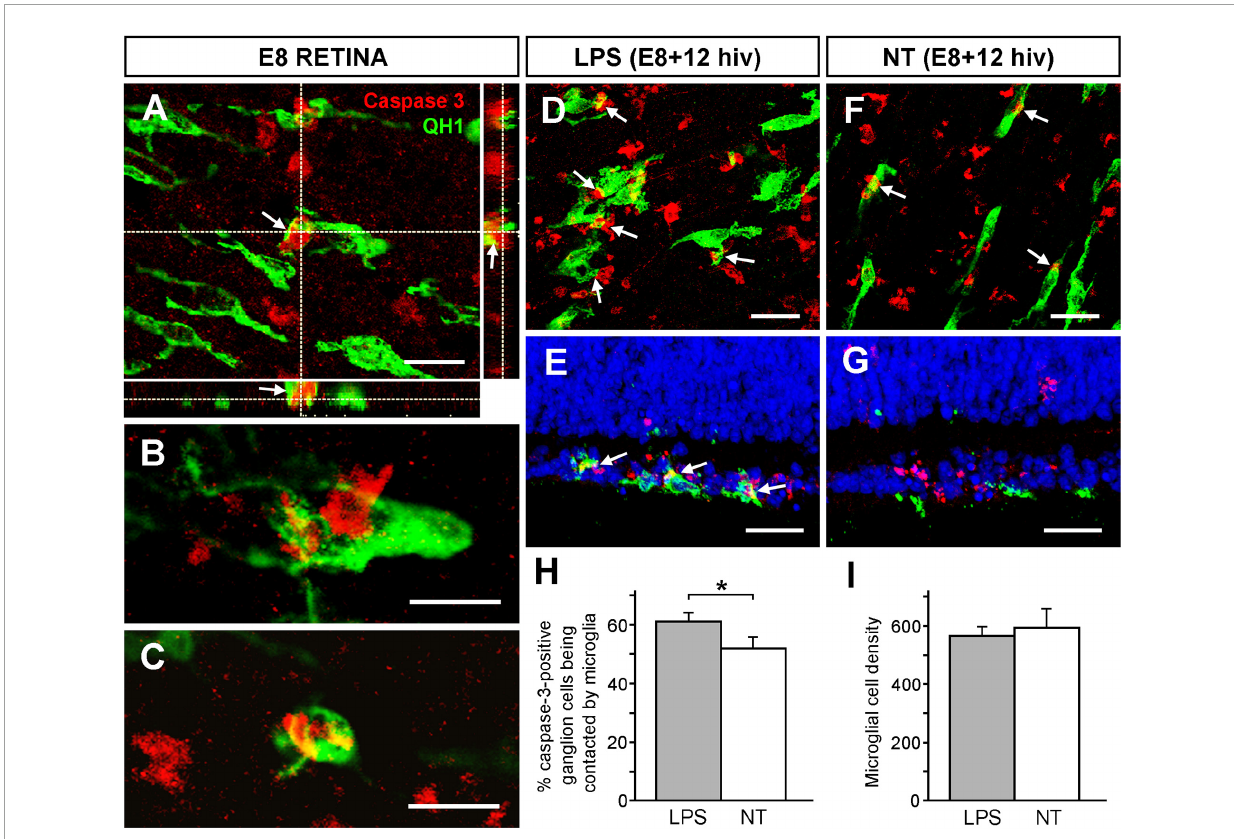
FIGURE4 Increase of phagocytic contacts between microglial cells and caspase-3-positive ganglion cells. The frequency of phagocytic contacts between microglial cells and caspase-3-positive ganglion cells increases in response to LPS treatment in retina explants from E8 quail embryos cultured for 12 h in vitro (E8 + 12 hiv). (A–C) Confocal images of microglial cells forming close engulfing contacts with caspase-3-positive ganglion cells in whole-mounted non-cultured E8 quail embryo retina explants, (E8 RETINA) double immunolabeled with QH1 (green) and anti-caspase-3 (red). These images are maximum-intensity projections from Z stacks of confocal optical sections throughout the thickness of the ganglion cell layer (GCL). Panel (A) shows a process from a microglial cell that contacts and embraces a caspase-3-positive ganglion cell. The XZ and YZ orthogonal projections corroborate the close contact (arrows) between the microglial cell process and the ganglion cell. Scale bar: 15 µ m. (B) Phagocytic contacts between a microglial cell soma and a caspase-3-positive ganglion cell are observed. (C) A caspase-3-positive ganglion cell completely engulfed by a microglial cell. Scale bars for panels (B,C) : 15 µ m. (D–G) Representative confocal images of whole-mounts (D,F) and cross-sections (E,G) from LPS-treated [LPS; (D,E) ] and non-treated [NT; (F,G) ] E8 + 12 hiv retina explants double immunolabeled with QH1 (green) and anti-caspase-3 (red) showing phagocytic contacts (arrows) between microglial cells and caspase-3-positive ganglion cells. Confocal images of whole-mounted explants are optical sections obtained in the ganglion cell layer. Cell nuclei in cross-sections were stained with Hoechst 33342 (blue) to visualize the retinal layers. Phagocytic contacts between microglial cells and caspase-3-positive ganglion cells are more abundant in LPS-treated explants compared to non-treated ones. Scale bars: 25 µ m. (H) Quantification of caspase-3-positive ganglion cells that are contacted by microglia in LPS-treated (grey bar) and non-treated (white bar) E8 + 12 hiv retina explants. Bars represent means ( ± SEM) of percentages obtained from counts in three different zones (dorsal, nasal and temporal) of whole-mounted explants ( n = 6 for each condition). The percentage of caspase-3-positive ganglion cells being contacted by microglia is significantly higher in LPS-treated than in non-treated explants (* P < 0.05, Student’s t-test). (I) Microglial cell densities in LPS-treated (LPS, grey bar) and non-treated (NT, white bar) E8 + 12 hiv retina explants. Data are presented as means ( ± SEM) of microglial cells per mm 2 obtained from counts in three square fields of 500 µ m × 500 µ m per whole-mounted retina explant ( n = 10 for each condition). No significant differences are detected between LPS-treated and non-treated explants.